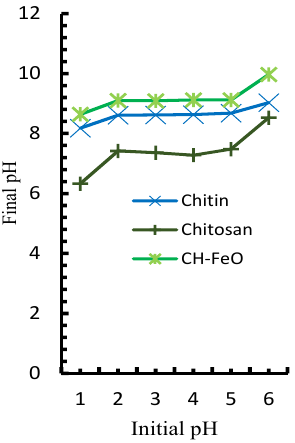
Fig. 4. Heavy metal adsorption versus changing pH with A) Chitin 0.15 g, B) Chitosan 0.2 g and C) CH-FeO nanocomposite 0.05 g The experiment conditions: 20 dm 3 solution, initial ion concentrations 10 mg/dm 3 , the mixing speed 5 rps, mixing time 1800 s, room temperature.